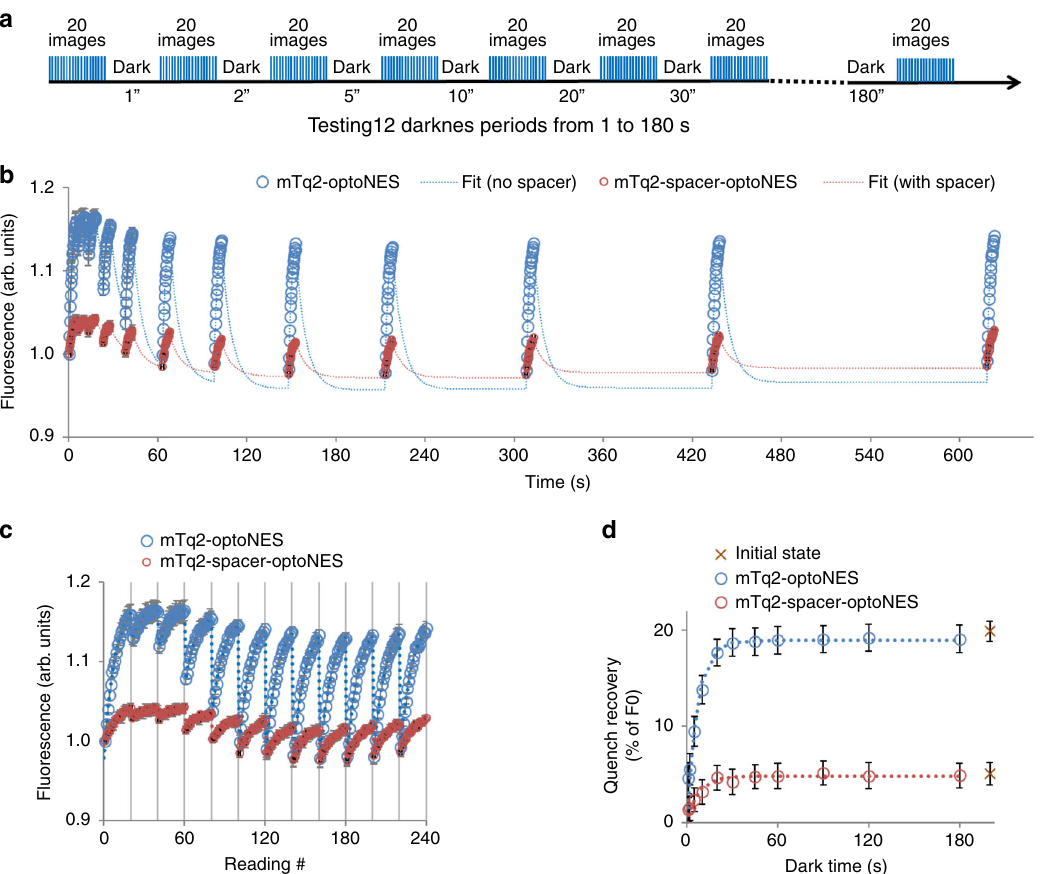
Fig. 3 Direct quanti fi cation of relaxation time as recovery from dequenching of mTurquoise by LOV2. a Illumination strategy to map LOV2 switching (changes in quenching) during illumination and relaxation-induced dequenching in darkness. Samples were exposed to 20 fl ashes (14 µ mol/m 2 438 nm) at ~4 Hz followed by 1 – 180 s darkness. b HEK293 cells expressing mTq2-optoNES (blue symbols) or mTq2-spacer-optoNES (red symbols) were imaged during the fl ash sequence as in a to induce dequenching followed by 12 sequentially increasing dark periods, allowing relaxation. The whole 240 image sequence was repeated three times per sample to reduce noise. Responses from each segmented cell (region of interest) in the fi eld and from each repeat were averaged. All wellwise-averaged data from transfected cells are normalised to an average of replicates for a corresponding mTurquoise-expressing sample (without LOV2) exposed to the same illumination conditions (Supplementary Fig. 10). Means are plotted against reading number. Each dequenching phase was fi tted to an exponential as in Fig. 3, with independent size and common activation rate constant for each protein, providing offset and amplitude estimates for each cycle. These curves, together with the dark-phase changes are shown as a solid line between the data points, showing goodness of fi t. Apparent activation rate constants at this photon fl ux were 0.12 and 0.11 per fl ash, equivalent to a photon sensitivity of 115 and 131 µ mol/ m 2 . c The same data as in b is plotted against reading number to more easily visualise the responses. Each grid-line represents an increasingly long dark period as shown in a , b . d The quench recovery estimated from the exponential curve fi ts in b / c , is plotted against the duration of dark time causing the quench. This reveals the time-dependence of recovery from dequenching. The data is fi tted to an exponential to derive relaxation time constants (~7 s for both constructs) and dequenching maxima. As evident from b and c , the dequenching is at maximum ~19 and 5% of initial fl uorescence for mTq2-optoNES and the spacer construct respectively. Source data are provided as a Source Data fi le. Data are presented as means± SEM; n = 6 wells for mTq2-optoNES and n = 5 wells for